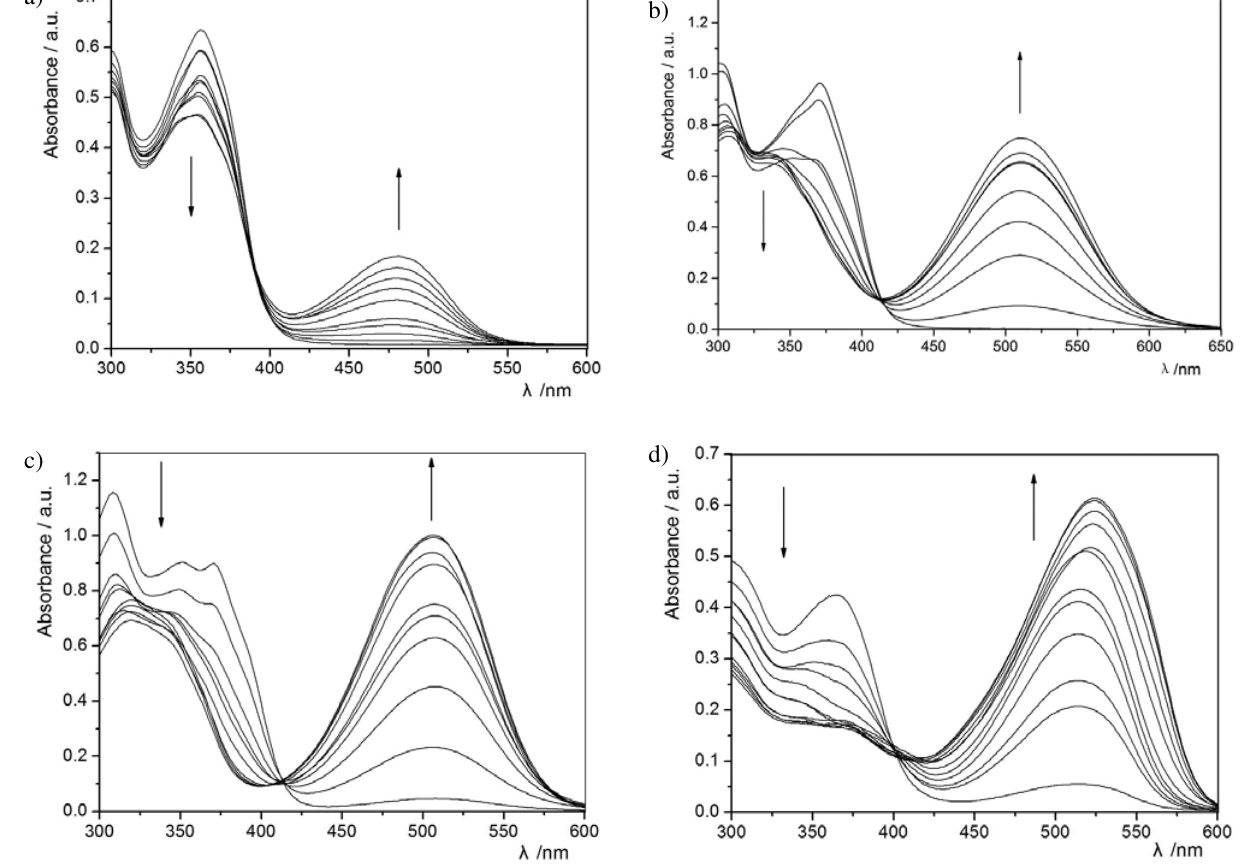
Fig. 2. UV-vis spectral changes of four compounds (4.0 × 10 –5 mol·L –1 ) upon the addition of AcO – (0–160 × 10 –5 mol·L –1 ), a) 1 , b) 2 , c) 3 , d) 4 ; Ar- rows indicate the direction of increasing anion